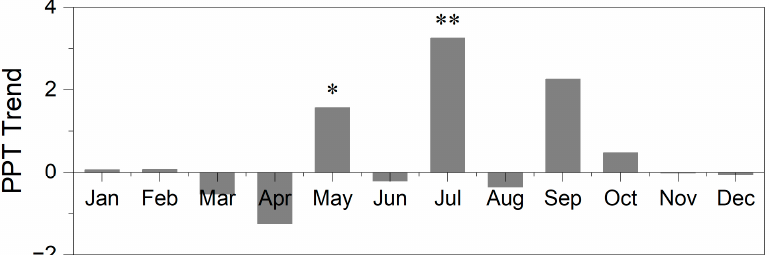
Figure 9. Trends of precipitation (PPT) in different months during 1997–2011. ** means significant change ( p < 0.05). change ( p < 0.1), ** means significant change ( p <